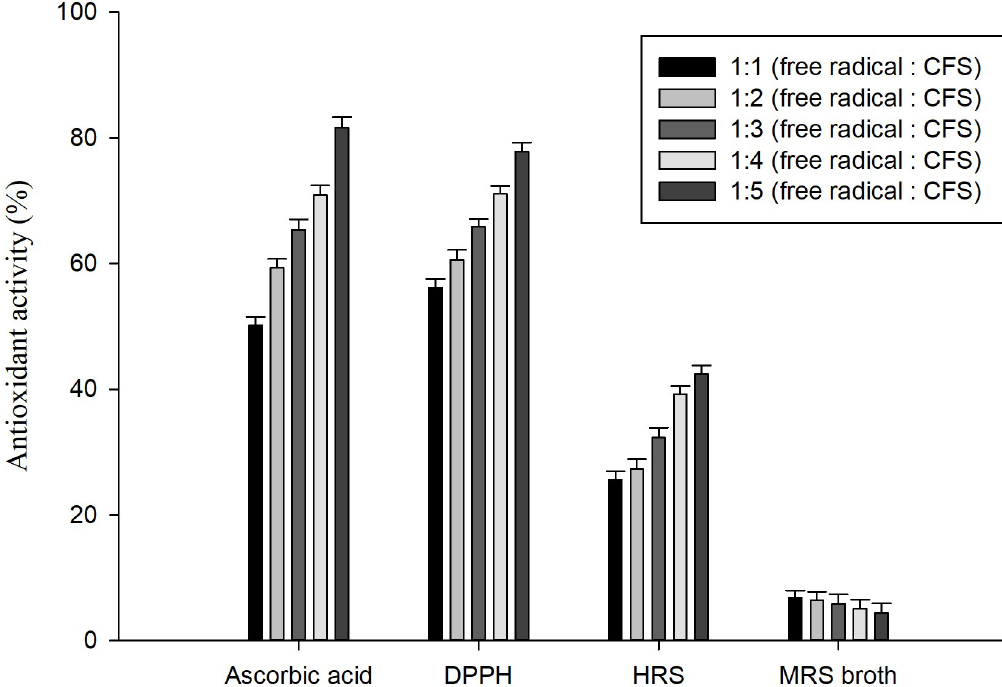
Fig 6. The antioxidant activity of P . pentosaceus OBK05. DPPH and HRS radical scavenging activities (%) using different concentration of CFS. Each value is expressed as (mean ± S.D, n = 3). MRS broth was treated as negative control and ascorbic acid as positive control. The error bars indicate a statistically significant difference at p < 0.05 within each row comparing the DPPH and HRS radical scavenging activity. https://doi.org/10.1371/journal.pone.0259702.g006 different time intervals. The lowering of cholesterol in cell-free supernatant (CFS) was observed continuously at different time intervals like 12 h, 24 h and 48 h. The quantity of cho- lesterol reduction from the growth medium was observed to be gradually increased from 17 to 67% (Fig 7C), which is comparably higher than the previous study where the P . pentosaceus LJR5 isolated from rumen liquor of goat showed 62% reduction [38]. Similarly, a previous